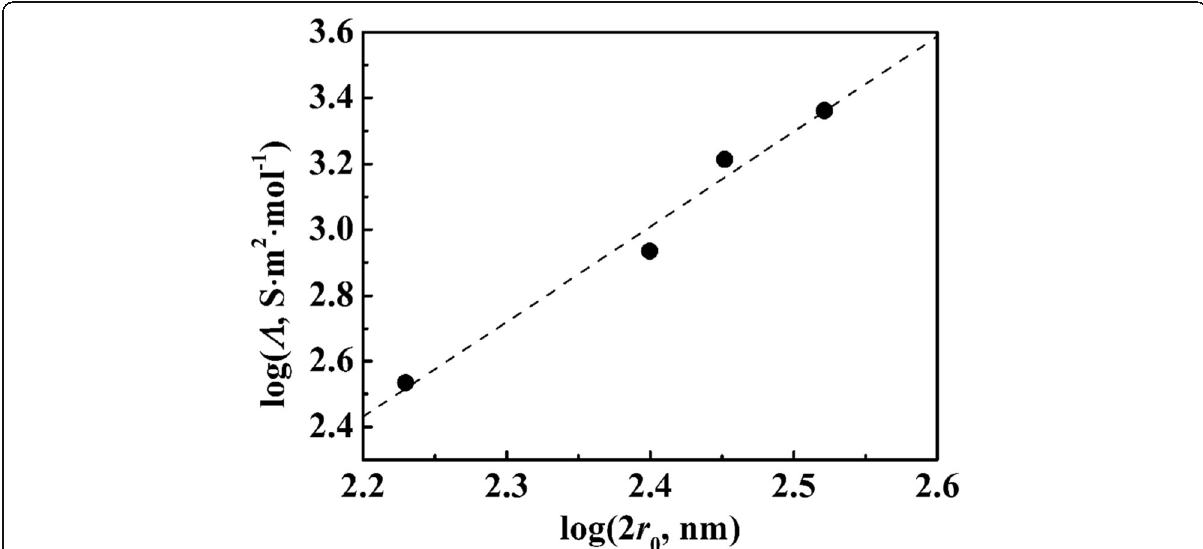
Fig. 4 Variation of the molar conductivity with the diameters for PSA suspensions in logarithmic